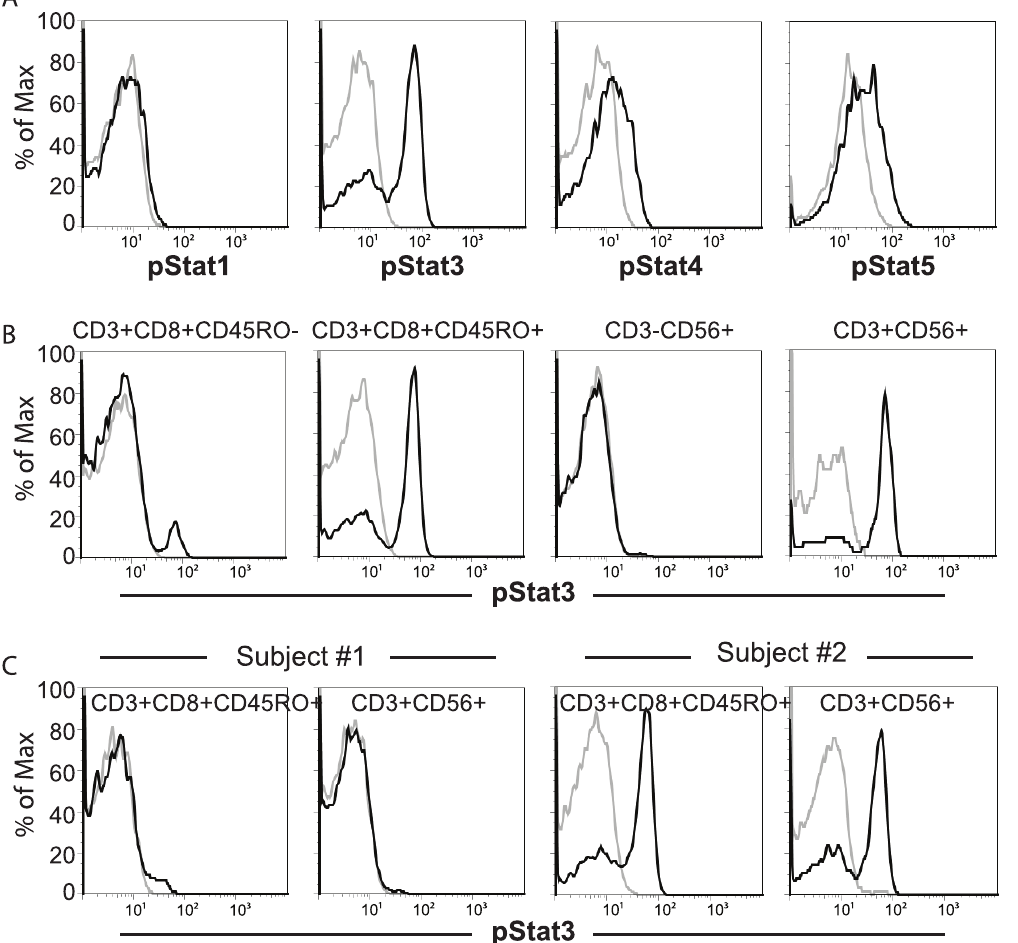
Figure 1. IL-23 stimulation of peripheral blood lymphocytes activates STAT proteins with inter-individual variability in IL-23 responsiveness. Peripheral whole blood was stimulated with 100ng/ml IL-23 for 15 minutes and IL-23-mediated pSTAT induction was assessed by phospho-flow assays for STAT1, 3, 4 and 5. (A) IL-23-mediated pSTAT induction in CD8 + CD45RO + memory T cells. Gray line and black lines represent pSTAT in un-stimulated and IL-23 stimulated samples, respectively. (B) IL-23-mediated pSTAT3 induction in CD8 + naı¨ve (CD45RO-) and memory (CD45RO + ) T cells, NK cells (CD3 2 CD56 + ), and NKT (CD3 + CD56 + ) cells. (C) Representative individuals showing low (subject # 1) or high (subject # 2) IL-23